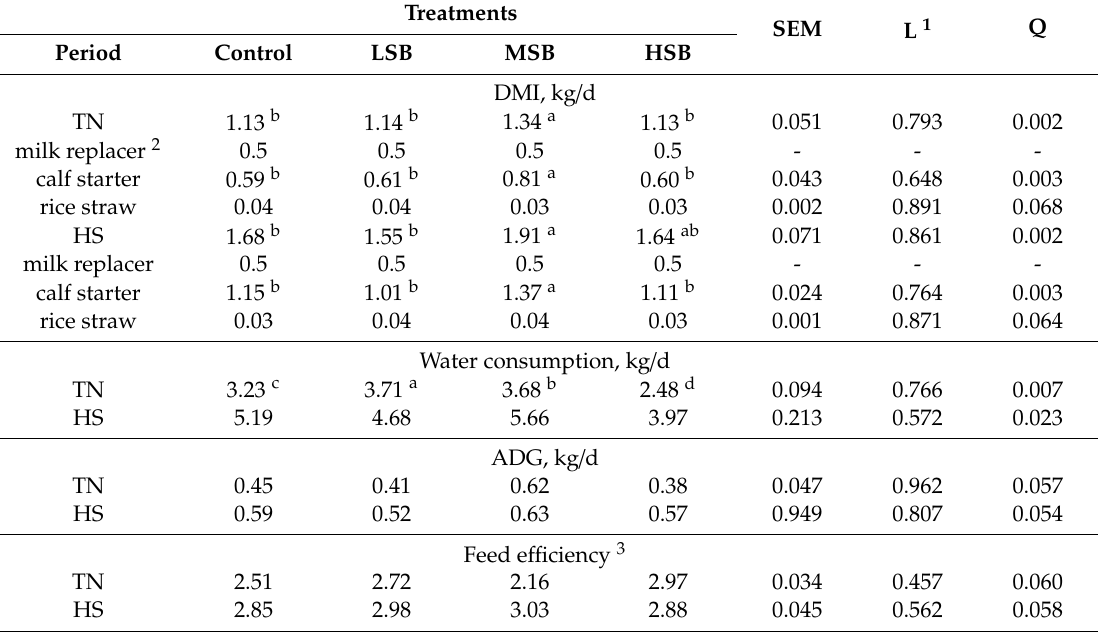
Table 2. Performance parameters of dry matter intake (DMI), water intake, average daily gain (ADG), and feed e ffi ciency of calves receiving Saccharomyces boulardii (SB) during the thermal neutral